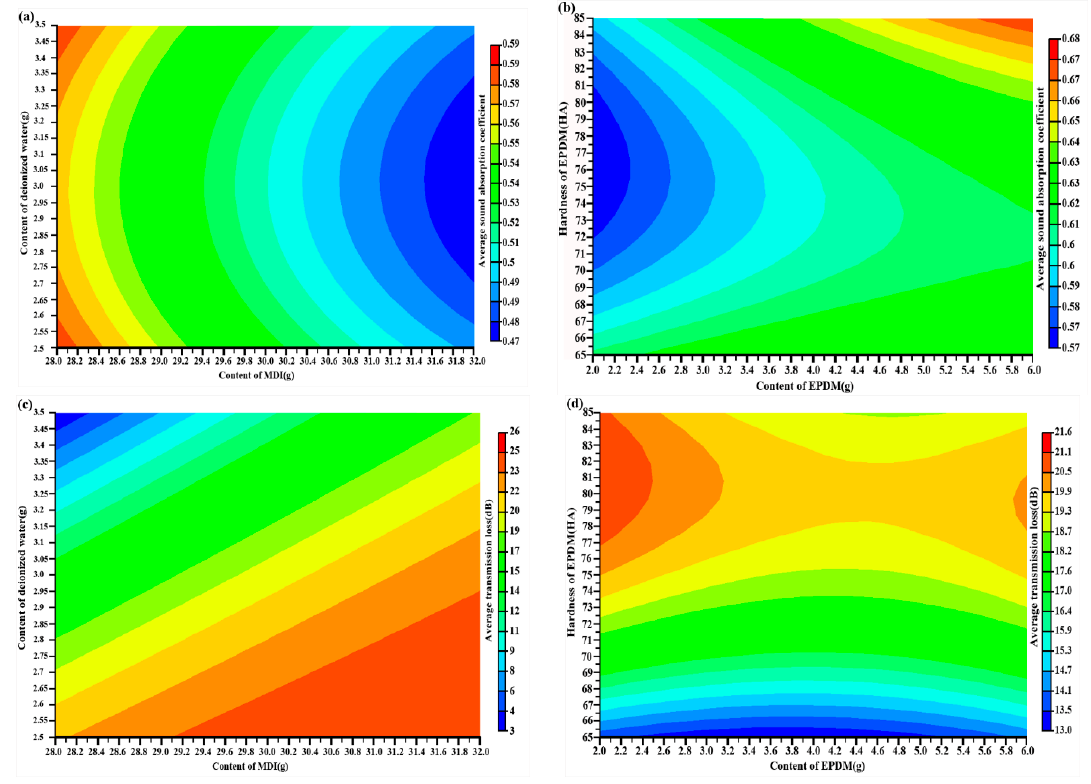
Figure 2. ( a ) Effect of chemical compositions on sound absorption ability; ( b ) Effect of functional particle on sound absorption ability; ( c ) Effect of chemical compositions on sound insulation ability; and ( d ) Effect of functional particle on sound insulation ability.